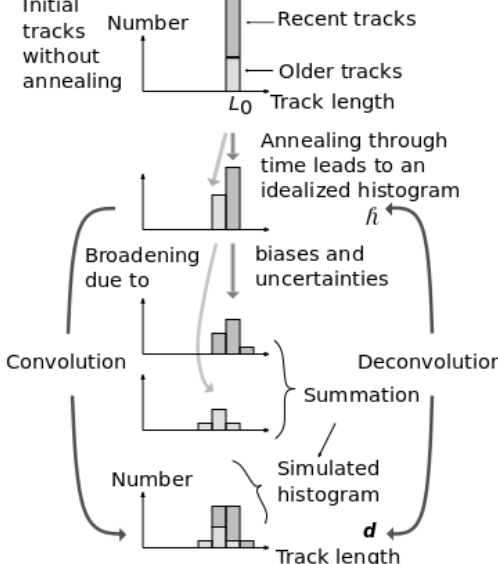
Figure 2. All randomly oriented tracks start with the length L 0 and are then annealed by time and temperature. At present, the track length histogram is , an idealized histogram without track length broadening effects. The most recent tracks appear in the right col- umn of . This histogram is broadened by convolution to mimic the histogram d , resembling a measured histogram. The broadening is caused by the initial length range, biases, and uncertainties. The convolution itself may be regarded as a summation of the broaden- ing of separate columns of . Deconvolution removes the broaden- ing of d